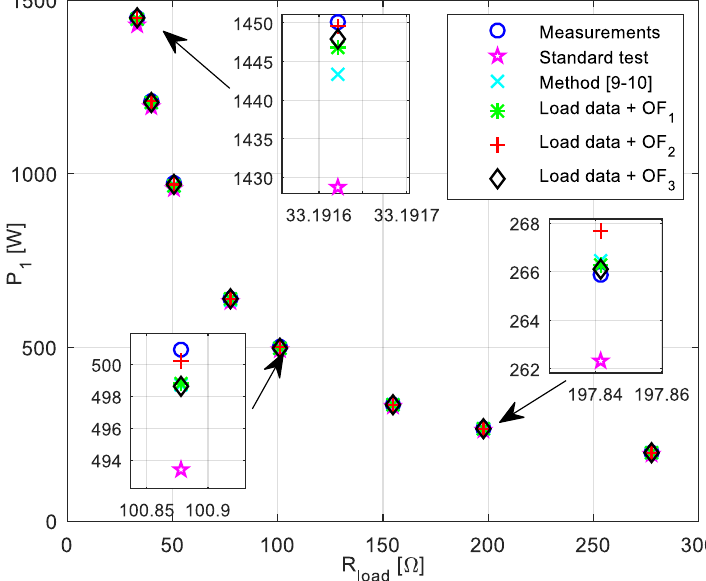
Figure 7. Input power versus load resistance referred to the primary side characteristics.